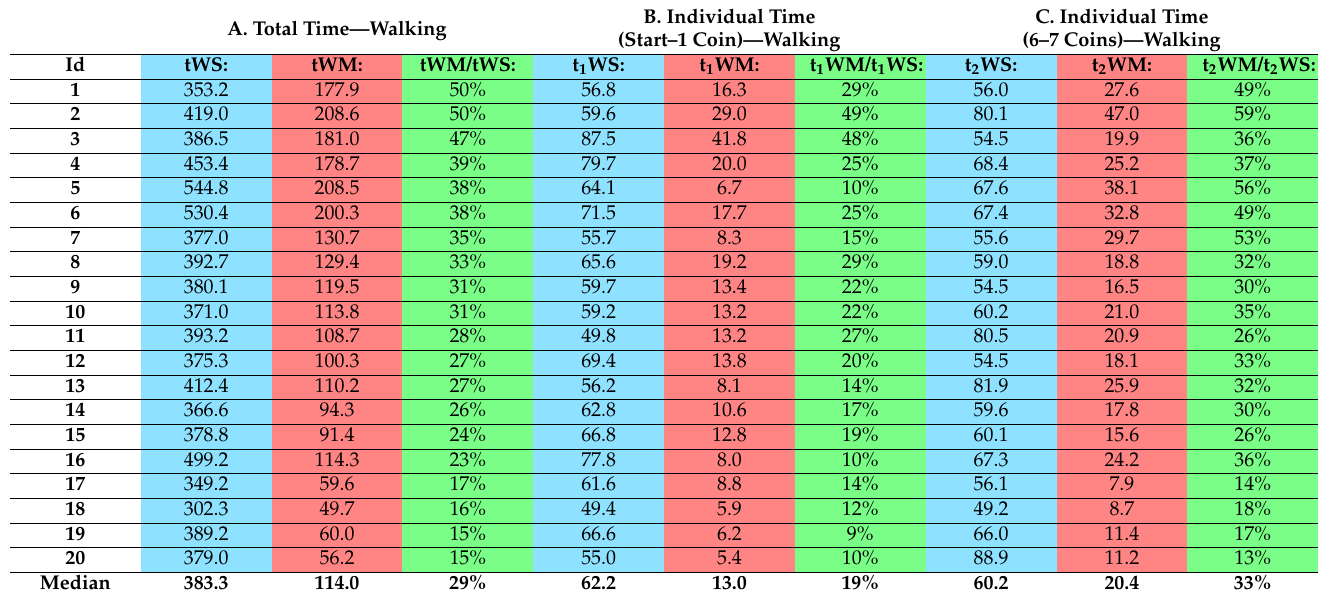
Table 1. Time data for walking (20 gamers). The total game time for walking gamers—tWS (time-Walking-Space), the mini-map examination time for walking gamers—tWM (time-Walking-Mini-map).